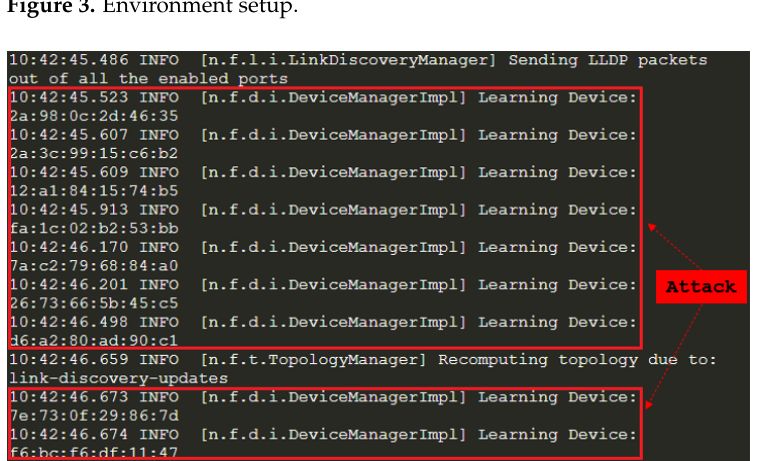
Figure 4. Floodlight with injection